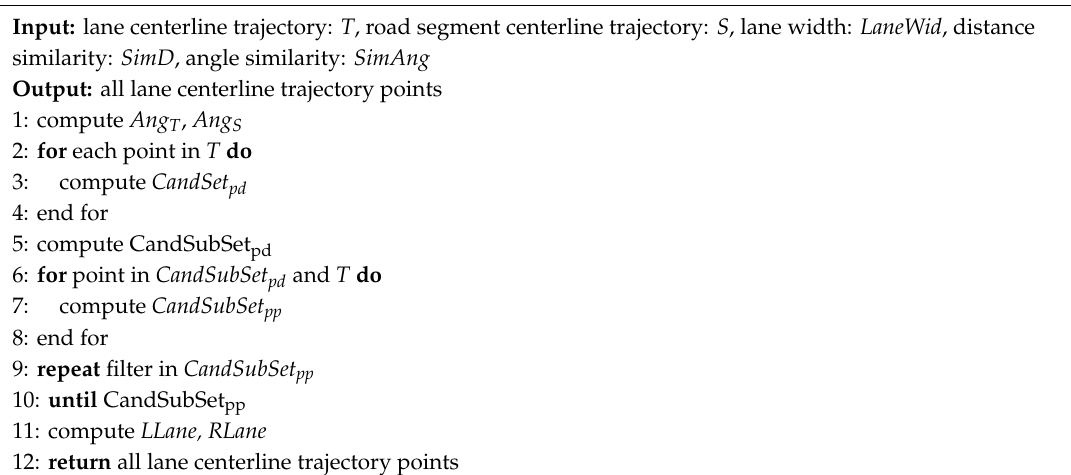
Algorithm 1 TSJ Pruning Based